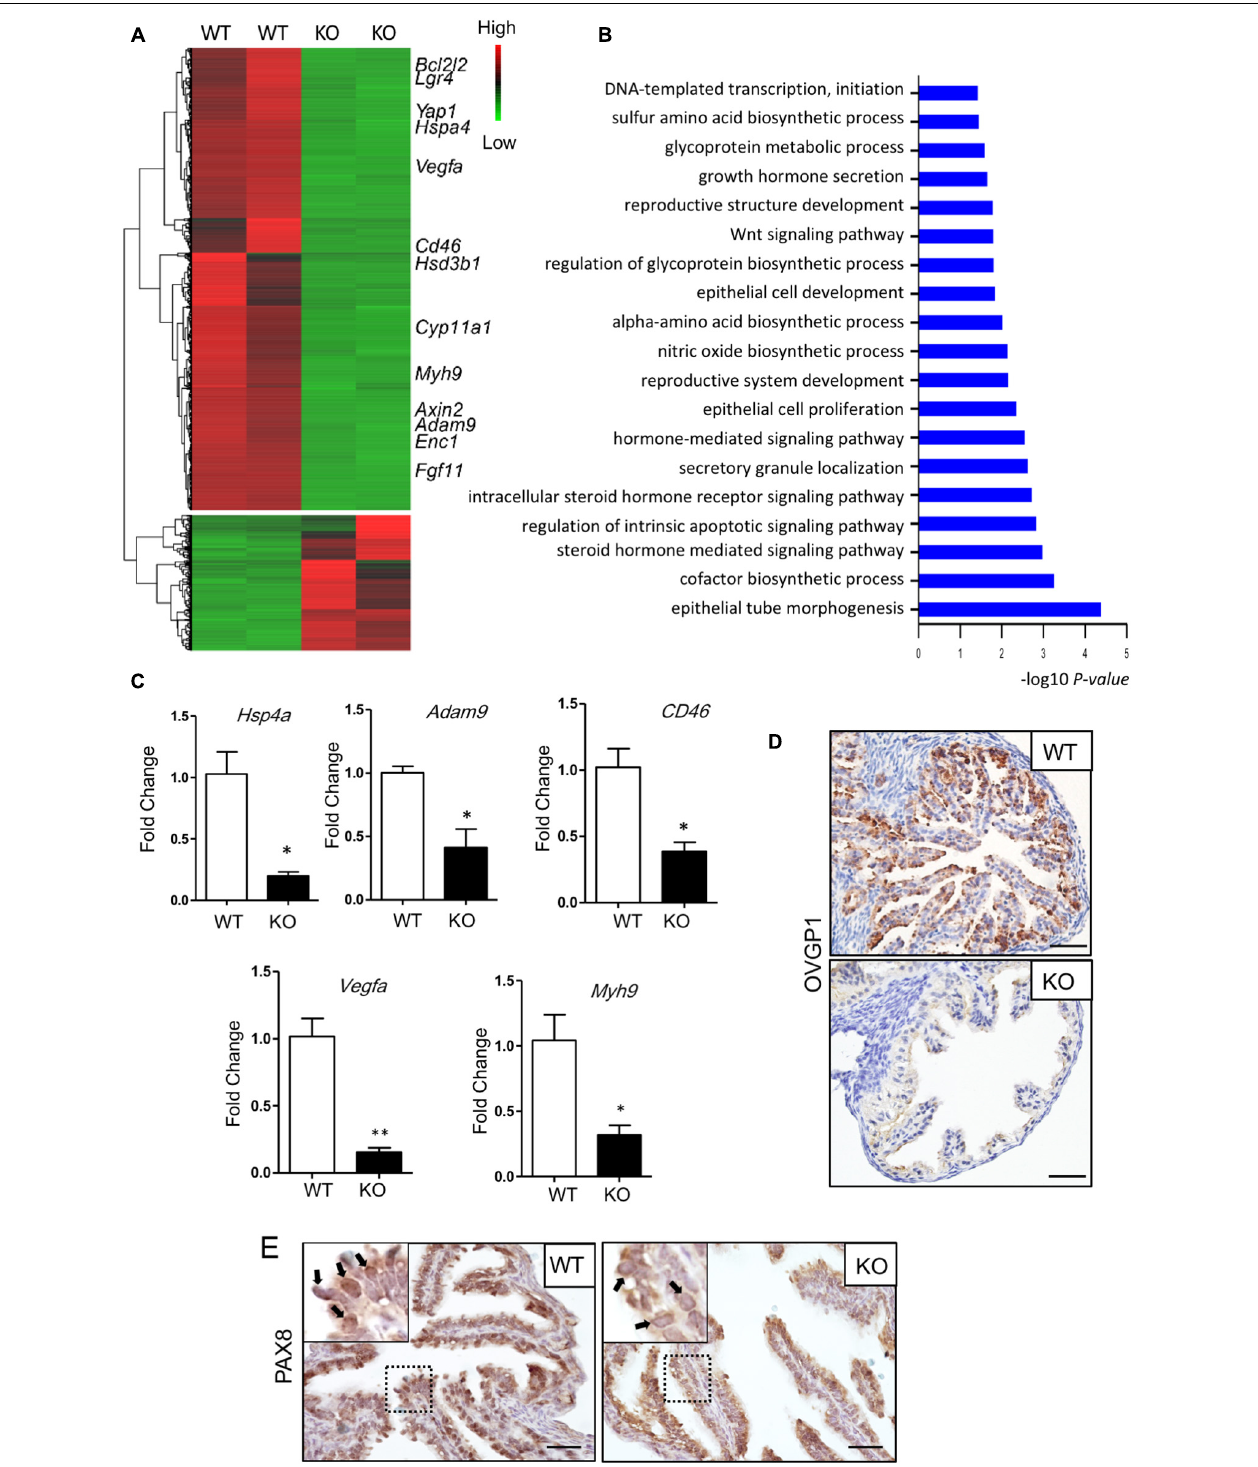
FIGURE 4 | Molecular defects in the oviduct of Lgr4 -deficient mice. (A) RNA-seq for mouse oviducts (the estrus stage). Clustered heat map of log2-transformed FPKMs showing the differentially expressed genes after LGR4 deletion. Indicated genes are marked on the right side of the heat map. (B) Gene Ontology analysis. (C) RT-PCR assay showing the relative changes of some representative small molecular factor genes. (D) IHC assays to detect the protein level of OVGP1 in the WT or Lgr4 -deficient oviducts. (E) IHC assays to detect the location of PAX8 in the WT and Lgr4 -deficient oviductal epithelial cells. ∗ p ≤ 0.05; ∗∗ p ≤ 0.01. Scale bar, 25 µ m in (D,E) . RT-PCR, reverse transcription polymerase chain reaction; IHC, immunohistochemistry.